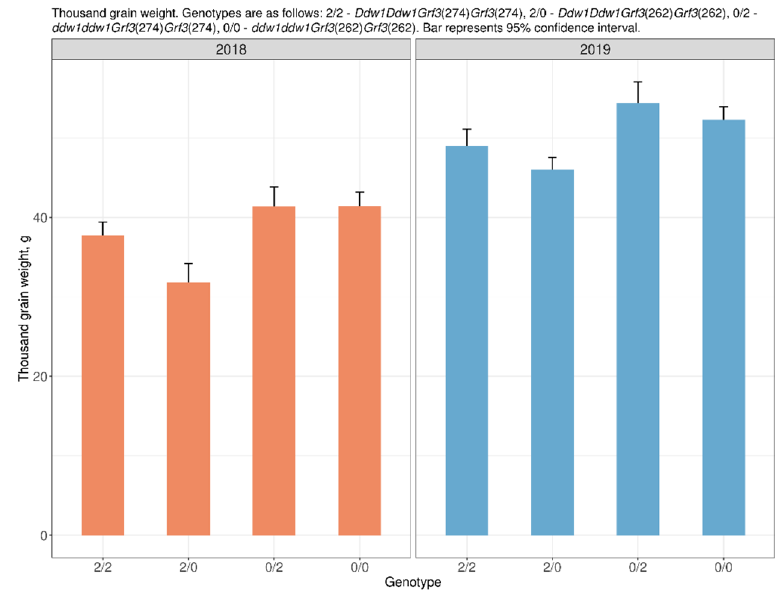
Figure 2. The effect of the allelic state of DDW1 and Grf3 on thousand grain weight.